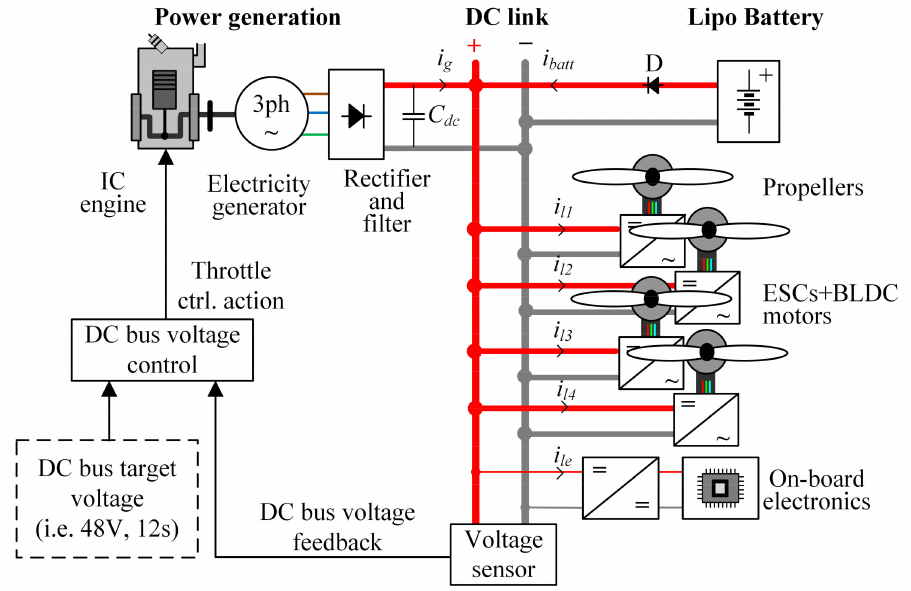
Figure 1. Considered hybrid power unit